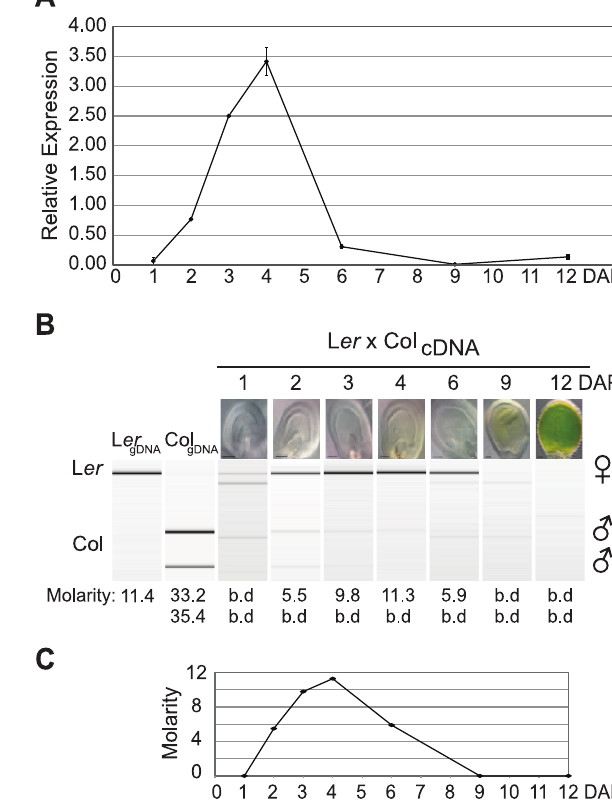
Figure 3. AGL36 is imprinted throughout its expression cycle. (A) AGL36 expression profile. Calculations were done using 3 DAP values as reference point, giving other obtained expression values relative to the 3 DAP expression level. Samples were taken at 1, 2, 3, 4, 6, 9, and 12 DAP. The graph represents the average relative expression values obtained from two independent biological parallels where the RNA from each biological sample gave rise to two independent cDNA syntheses (technical replica). The indicated STDEV is derived from the two independent biological parallels. The AGL36 transcript levels were normalized to ACT11 levels. (B) RT-PCR digest of the SNP containing region analyzed by the Bioanalyzer show that AGL36 imprinting is maintained throughout seed development. Samples were taken at time-points as indicated for each lane. A representative light micrograph of each DAP stage is shown. Only maternal (L er ) AGL36 expression was found when present. Genomic L er and Col DNA were included as controls. 100 ng DNA/cDNA was used as template for each PCR reaction. The intensities of the bands are represented as concentrations (nmol/L). Note, weak paternal bands obtained at 2 DAP were below the detection limit for measurement on our instrument (0.1 ng/ m l , 0.4 nmol/L). Intensities below the detection point of the instrument are indicated as b.d. The displayed SNP picture is representing one of four independent runs (2BR and 2TR). (C) Visual representation of the obtained intensities of maternal bands in B) represented as concentrations demonstrated that AGL36 was imprinted and only maternally active throughout its expression cycle. Furthermore, the 1.7 Kb promoter fragment used in this analysis appears to be sufficient to confer parent-of-origin specific expression of the reporter. AGL36 is not required for seed survival To further investigate the biological function of AGL36 , we screened the Koncz T-DNA collection for insertions [48]. We identified a mutant line, agl36-1 , harboring a single T-DNA